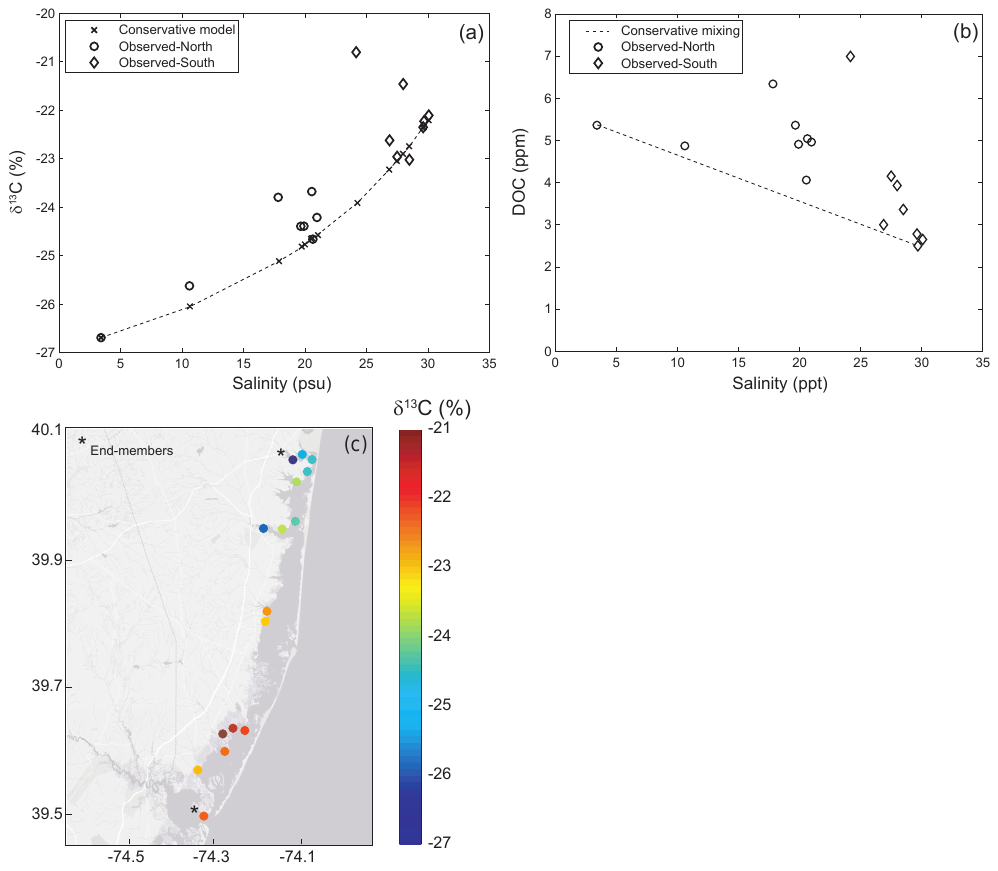
Figure 5. (a) Measured δ 13 C-DOC values and salinity for both North and South Barnegat Bay are plotted against an isotopic conserva- tive mixing model for location. Deviations from the model suggest contributions of DOC that is distinct from the assumed end-members. (b) Measured DOC concentration and salinity for Barnegat Bay are plotted along with a line of concentration-based conservative mixing between end-members. Data points with concentrations greater than those predicted by conservative mixing indicate addition of DOM to the system. (c) Spatial plot of isotopic signatures measured at Barnegat Bay. Asterisks indicate assumed